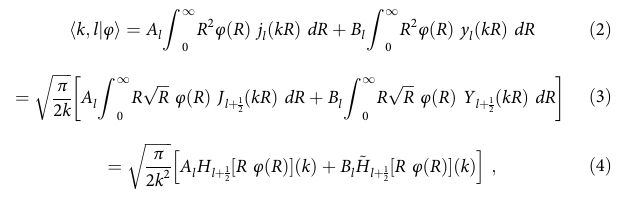
q ffiffiffiffiffiffiffiffiffiffiffiffiffiffiffiffiffiffiffiffiffiffiffi (cid:3) J ð J þ 1 Þ (cid:3) 3 4